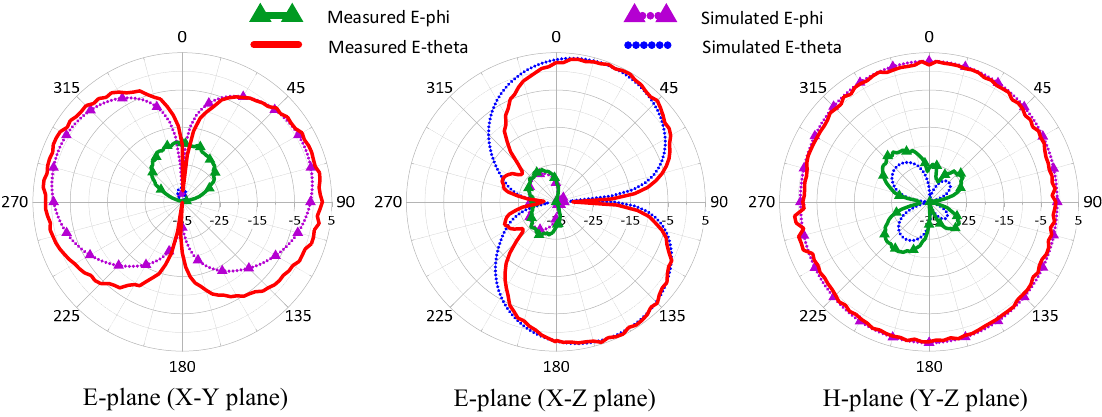
Figure 8. Measured and simulated vertical polarization mode radiation patterns at 2.45 GHz.